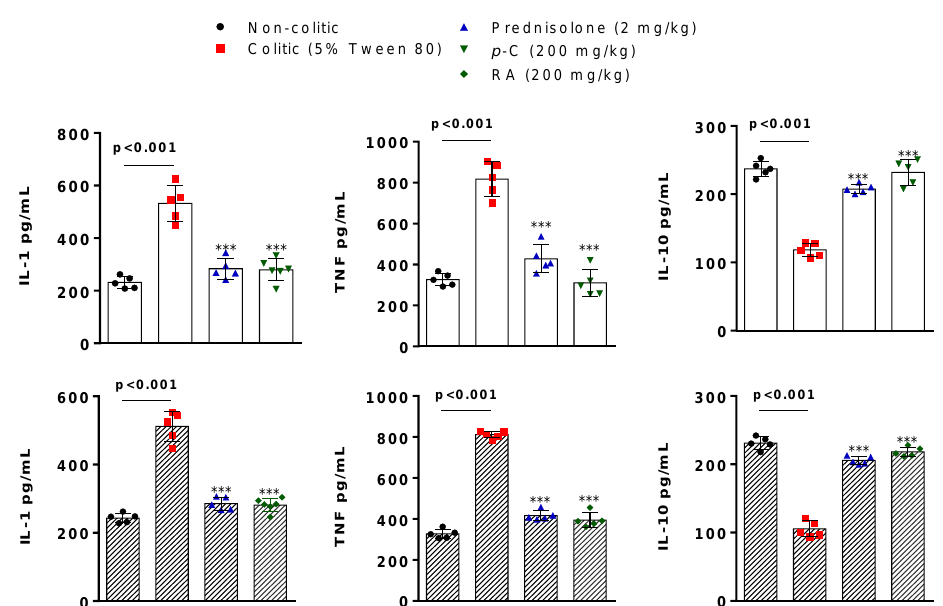
Figure 4. Effect of oral administration of p- C and RA on interleukin (IL)-1β, tumor necrosis factor (TNF)-α, and IL-10 levels in colonic tissue from TNBS-induced ulcerative colitis in rats. Data are expressed as mean ± standard error, having been analyzed by one-way ANOVA followed by Dunnett’s or Tukey’s test. *** p < 0.001, compared to 5% Tween 80 or 0.9% NaCl control groups ( n = 5–6).